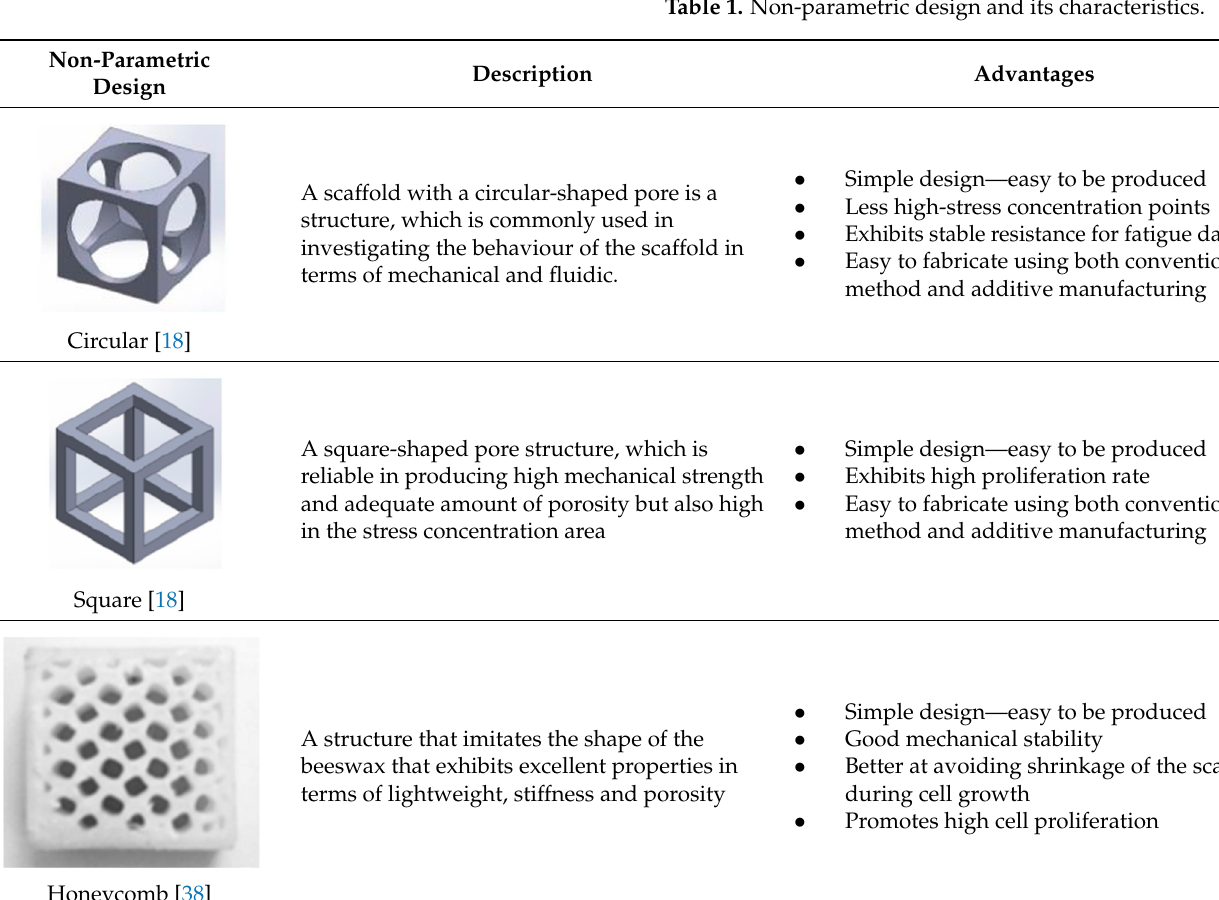
Table 1. Non-parametric design and its